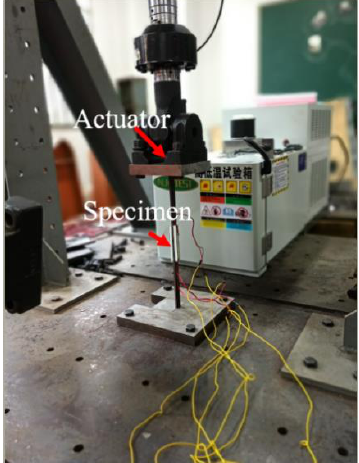
Figure 3. Quasi-static test setup.